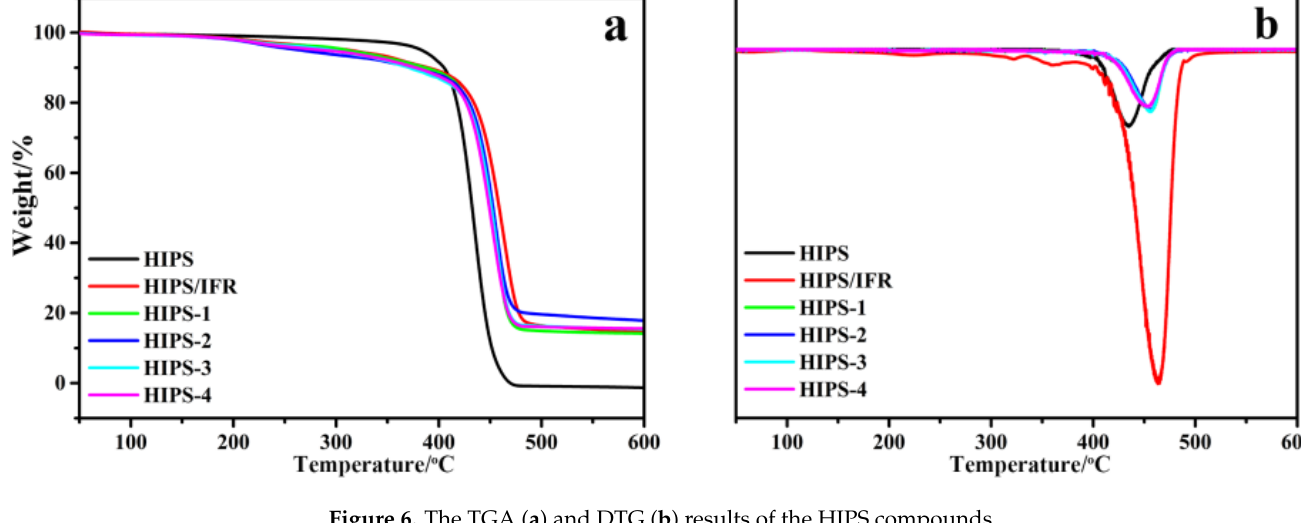
Figure 6. The TGA ( a ) and DTG ( b ) results of the HIPS compounds. Table 2. The related parameters of the HIPS compounds. Samples